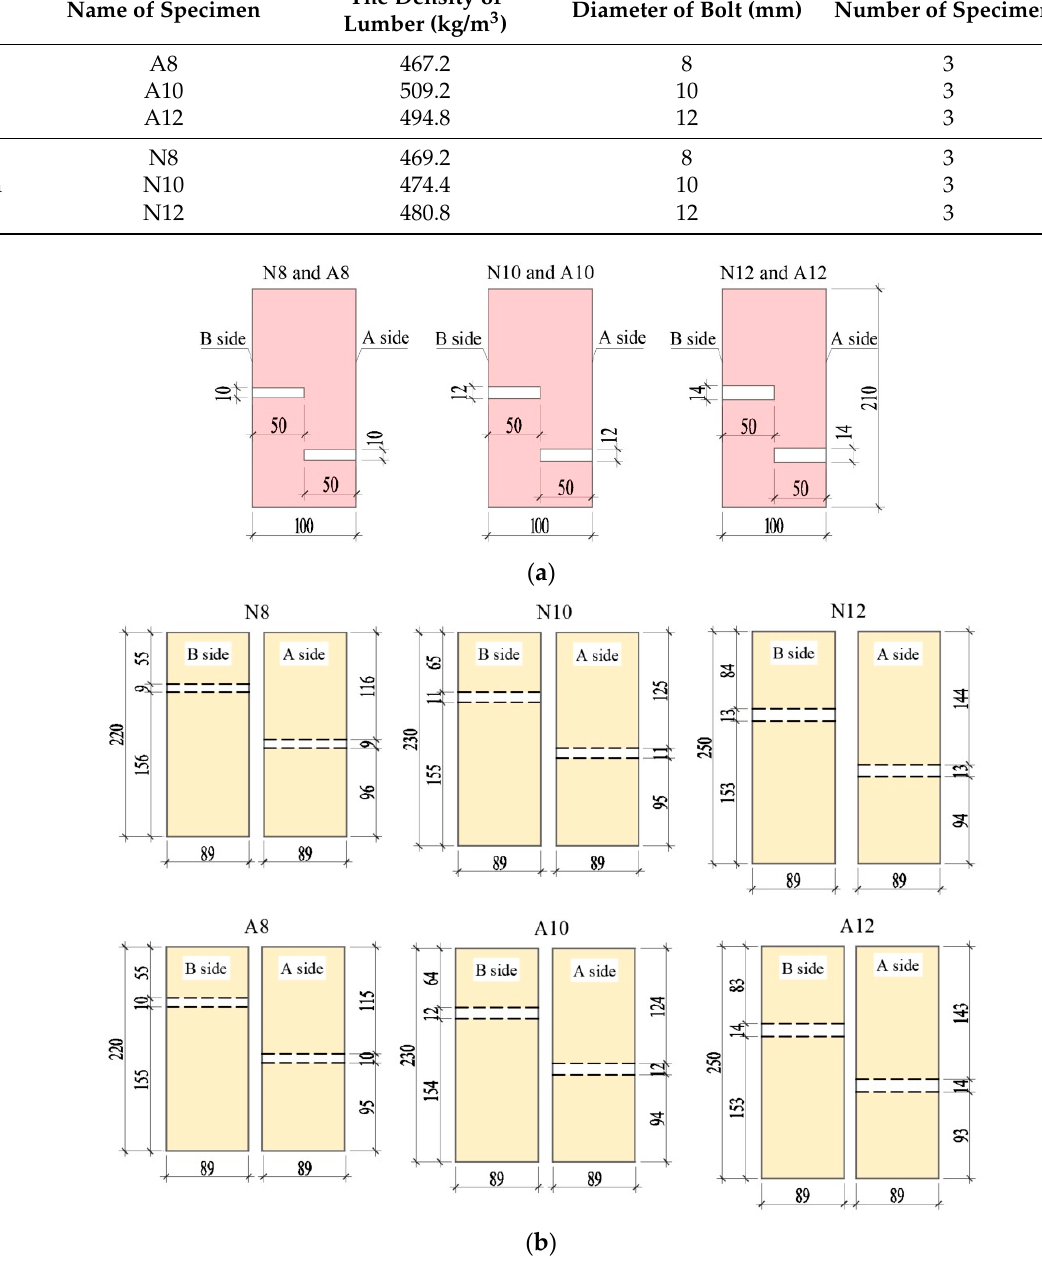
Figure 5. Dimension and bolt position. ( a ) Brick; ( b ) SPF lumber.